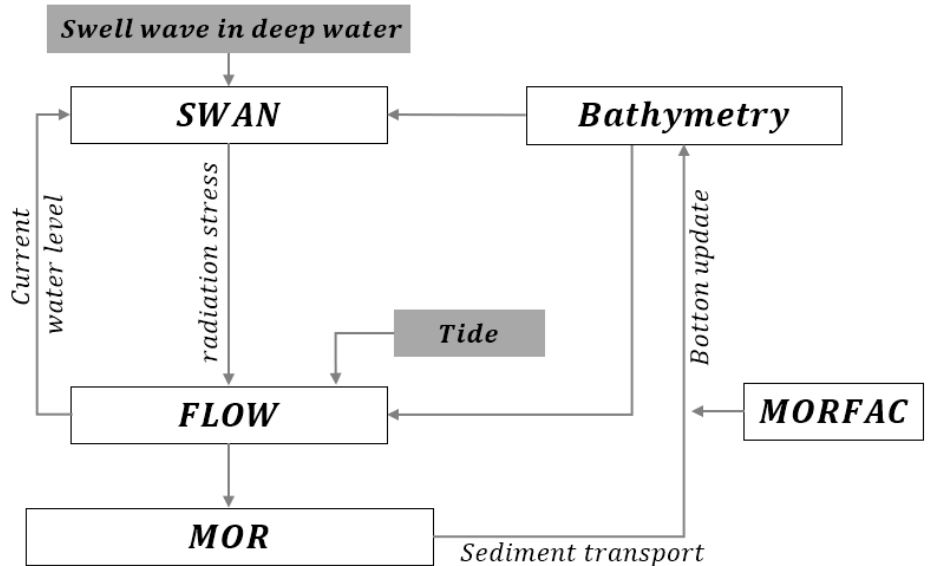
Figure 3. Online updating scheme of the Delft3D modules.